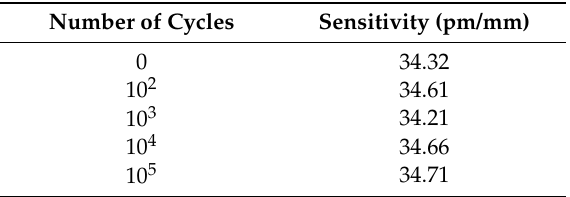
Table 1. Changes of sensitivity under alternating displacement test.